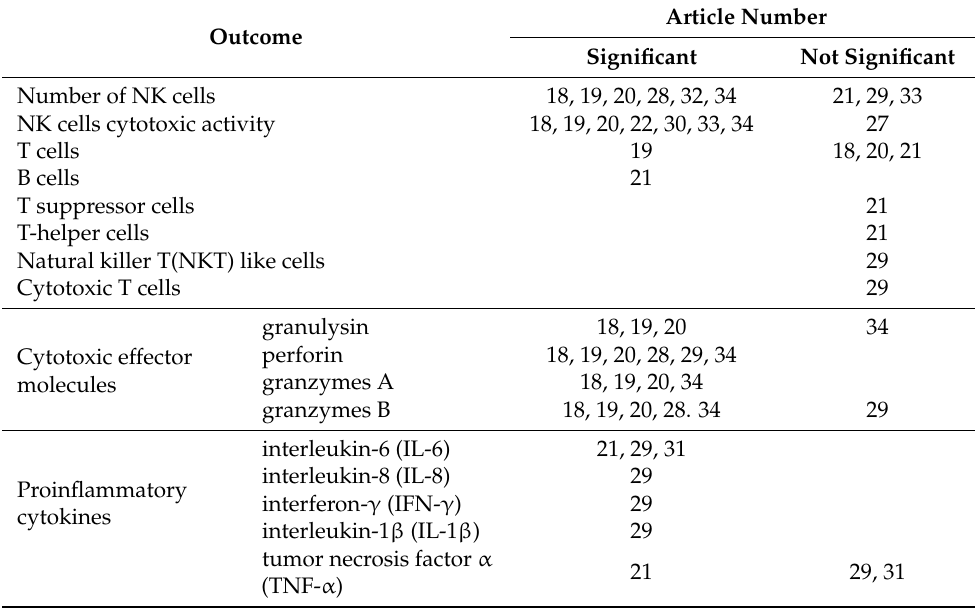
Table 3. Summary of the effects of forest therapy on immune